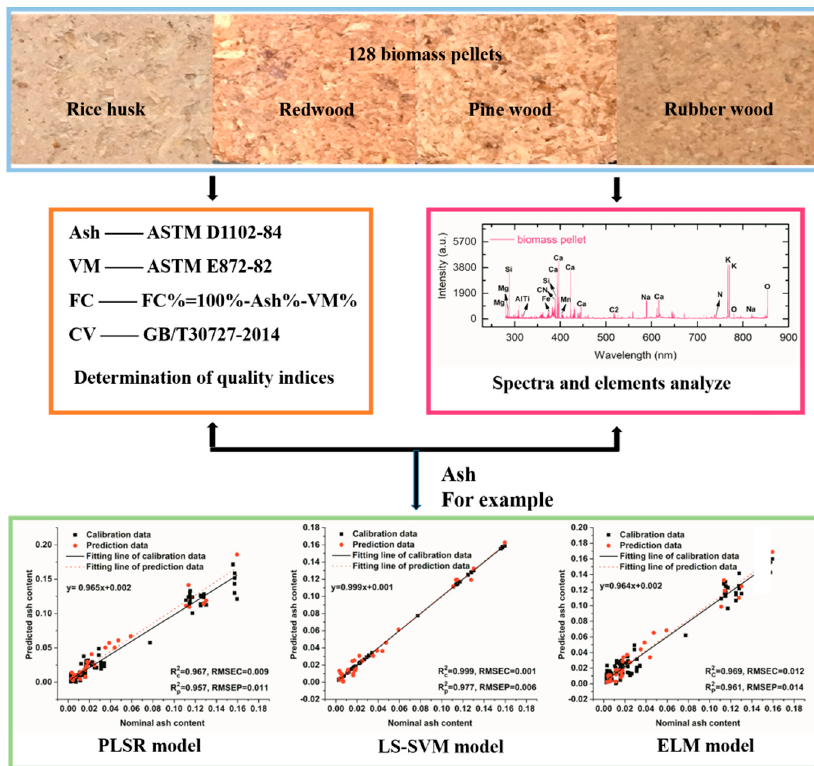
Figure 2. Flowchart of data analysis for quality indexes prediction of biomass pellets.